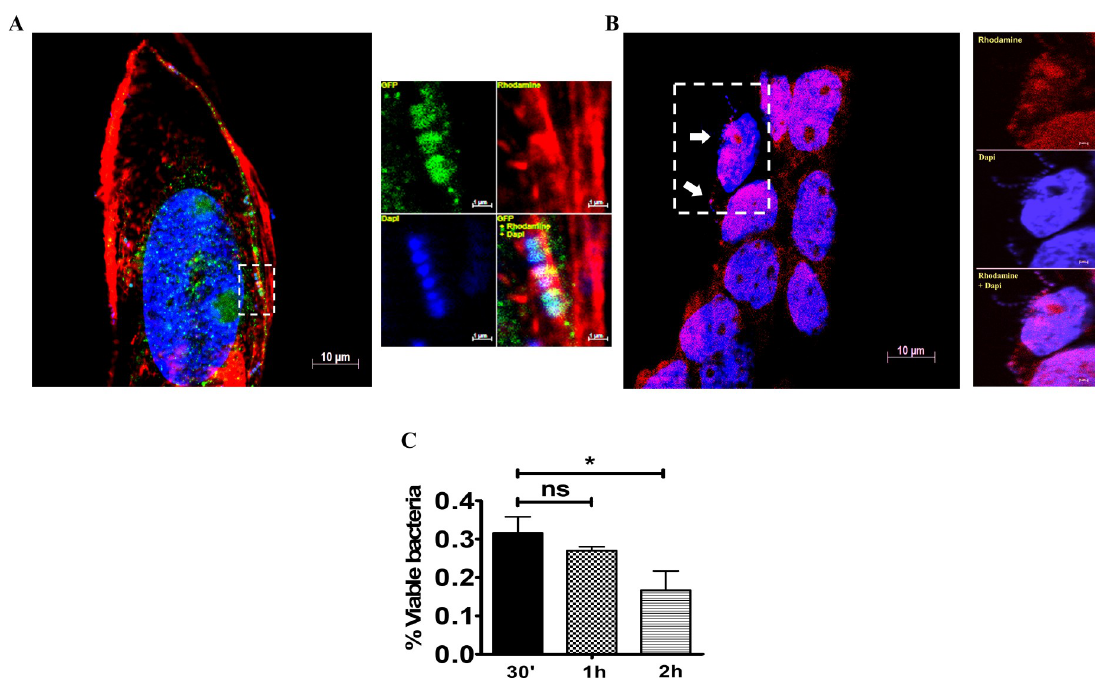
Fig 6. Colocalization of GBS with endosomal markers. Five-day-old islets were infected with GBS and stained for endosomal markers. (A) Co-localization of invading streptococci (Blue) with the early endosomal marker EEA-1 (Green) and actin filaments (Red) just below the cell membrane at 30 min after infection. Scale bar = 10 μ m. EEA-1 was stained using rabbit polyclonal antibodies followed by Alexa Fluor 488-conjugated anti-rabbit IgG. The right panels are magnifications of the area indicated by the dashed rectangle. Scale bar = 1 μ m. (B) Colocalization of GBS (Blue) with acidic endosomes (Red) at 2 h post-infection. White arrows indicate bacteria. The right panels are magnifications of the area indicated by the dashed rectangle. Scale bar = 1 μ m. (C) CFU counts in cell lysates at different times after treatment of 5-day-old Caco-2 islets with antibiotics to kill extracellular bacteria. Shown are means ± SD of three independent experiments conducted in triplicate. � , p < 0.05; by one-way Anova and Bonferroni test.